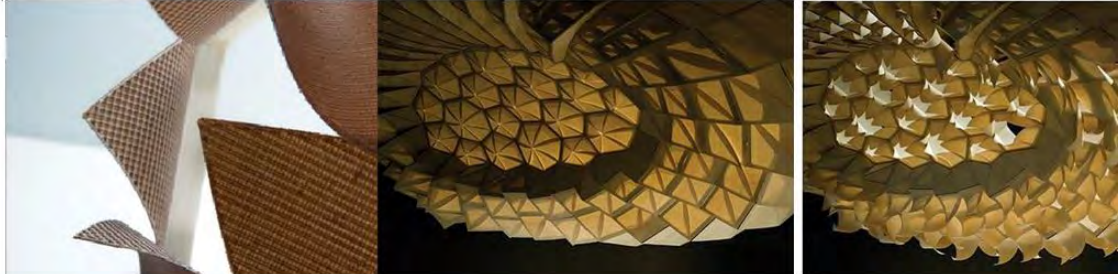
Figure 4. 3D-printedenvironmentally responsive material systems, University of Stuttgart 2014.David Correa, Steffen Reichert and Achim Menges/Achim Menges Architect BDA andInstitute for Computational Design (ICD).